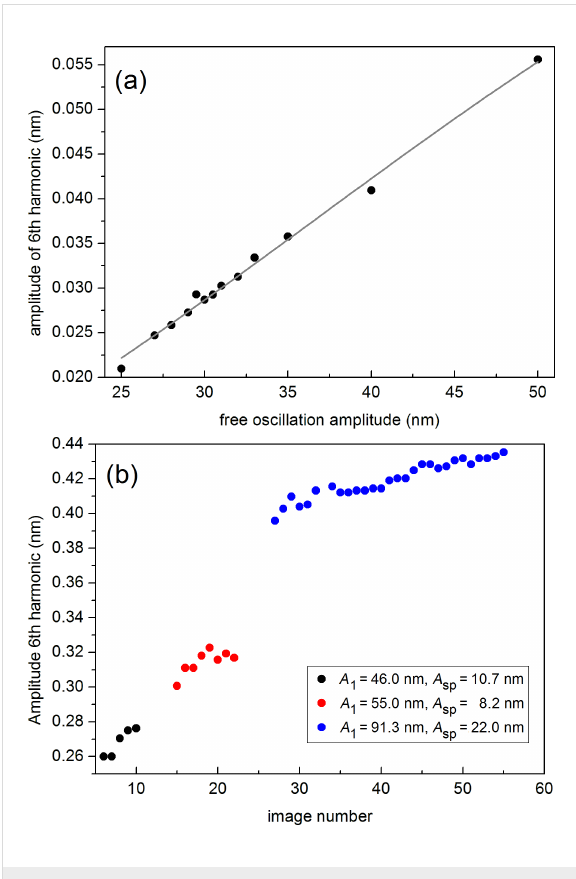
Figure 7: (color online) (a) Experimental evolution of A 6 as a function of the free oscillation amplitude using 26 N/m cantilevers. The fit to Equation 4 leads to g 1 = 3,016.794, g 2 = 38.23 nm − 1 and g 3 = − 569.14 nm − 1/2 . (b) Evolution of the mean value of the amplitude of the 6th harmonic extracted from the amplitude images simulta- neously acquired with the topography and phase images. The ampli- tude has been calibrated using the sensitivity determined from ap- proach curves. The experiments have been performed with a k c = 3.1 N/m rectangular AFM cantilever with a resonance frequency of 74.46 kHz and Q = 231, as determined with the thermal tune method, on silicon surfaces. The time evolution is expressed in terms of sequentially acquired images. Three different A 1 and A sp pairs have been used: A 1 = 46.0 nm, A sp = 10.7 nm (black full dots), A 1 = 55.0 nm, A sp = 8.2 nm (red full dots) and A 1 = 91.3 nm, A sp = 22.0 nm (blue full